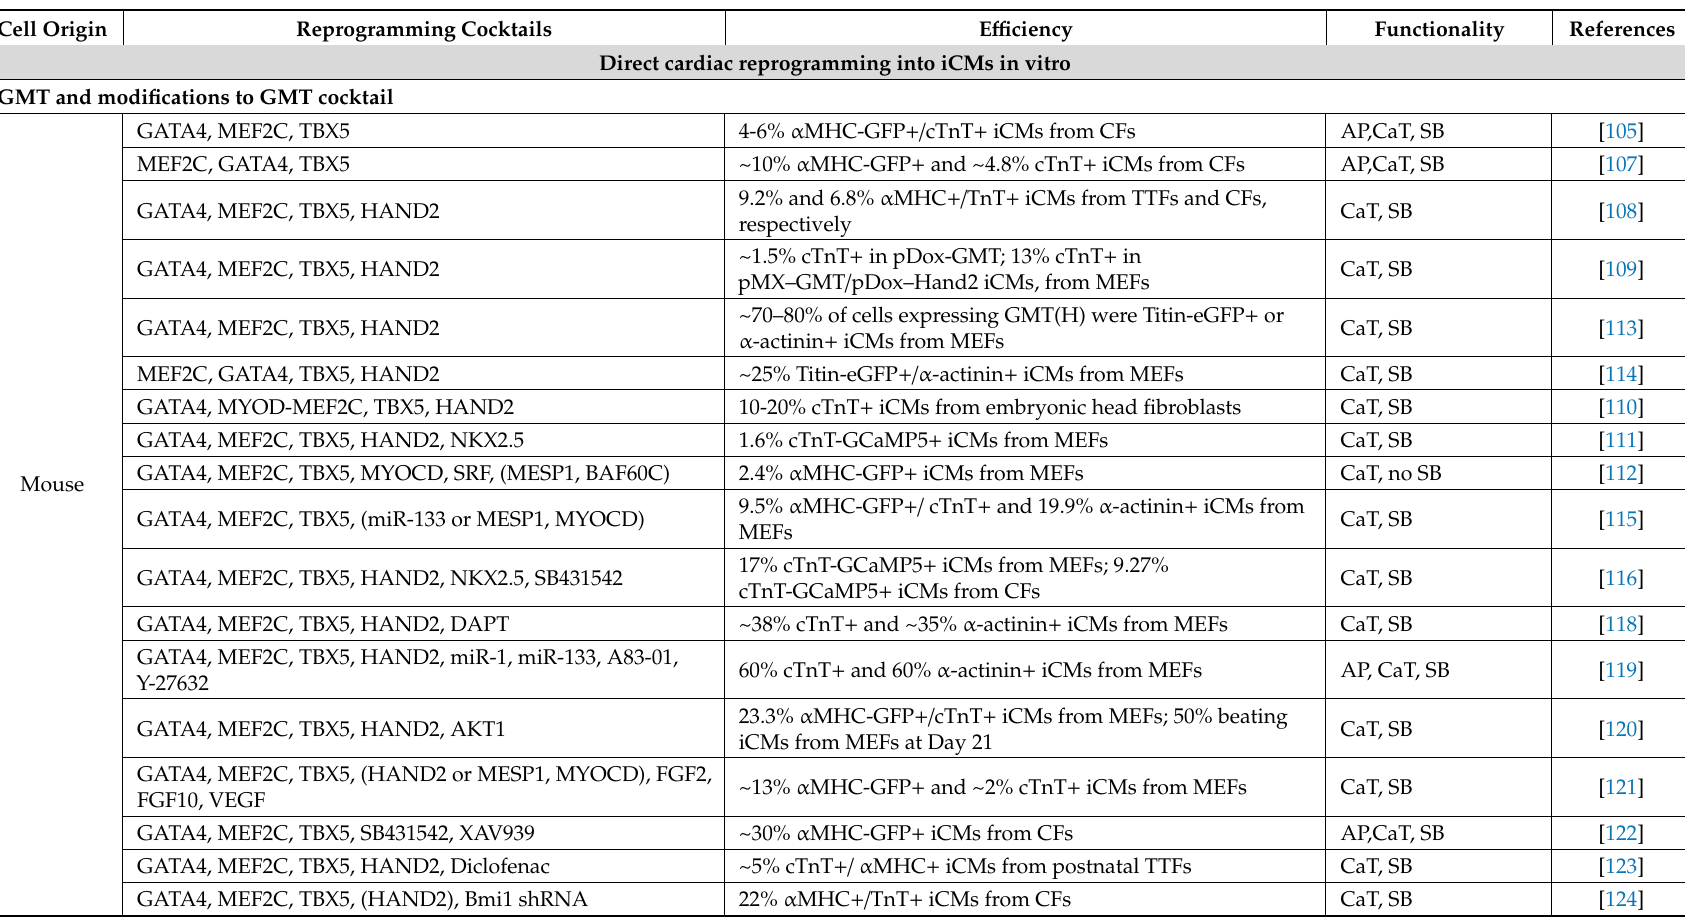
Table 1. Summary of reprogramming cocktails used for direct cardiac reprogramming. Abbreviations: iCMs: induced cardiomyocytes; CFs: cardiac fibroblasts; TTFs: tail-tip fibroblasts; MEFs: mouse embryonic fibroblasts; hESC: human embryonic stem cell; HDFs: human dermal fibroblasts, HCFs: human cardiac fibroblasts; HFFs: human foreskin fibroblasts; ND: not defined; AP: action potentials; CaT: calcium transients; SB: spontaneous beating; c-B: beating when co-cultured with murine CMs; iCPCs: induced cardiac progenitors; Tri-lineage dif.: tri-lineage di ff erentiation potential; ReV: retrovirus; SeV: Sendai virus vector; AV: adenovirus; LeV: lentivirus; HF: heart function; CS: cardiac tissue